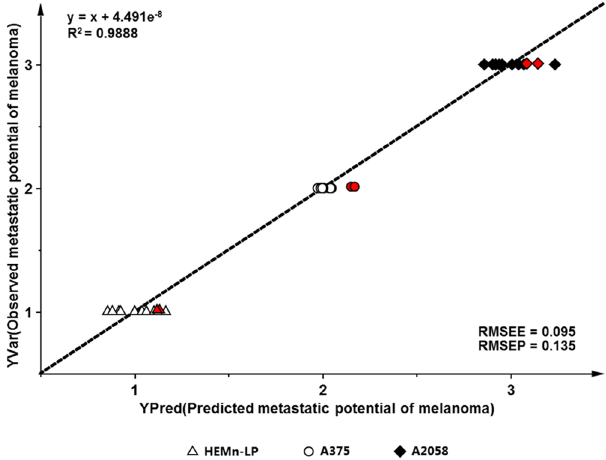
Figure 3. Establishment and validation of the PLSR model for prediction of the metastatic stage of melanocyte and metastatic melanoma cells (calibration dataset, n = 10, black and white; validation dataset, n = 2,